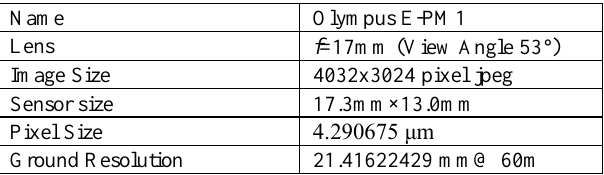
Table 2. Specification of Digital Still Camera